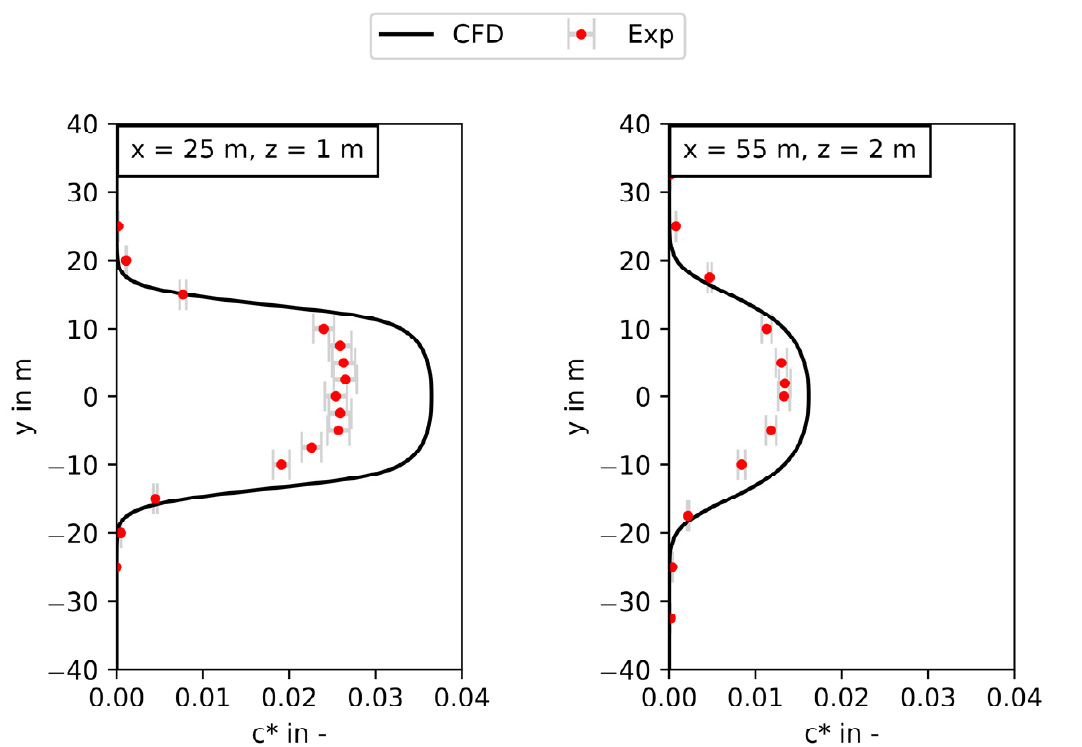
Figure 6. Neutrally buoyant gas cloud width in a distance of 25 m ( left ) and 55 m ( right ) to the origin, corresponding to 5 m and 35 m to the source, respectively.